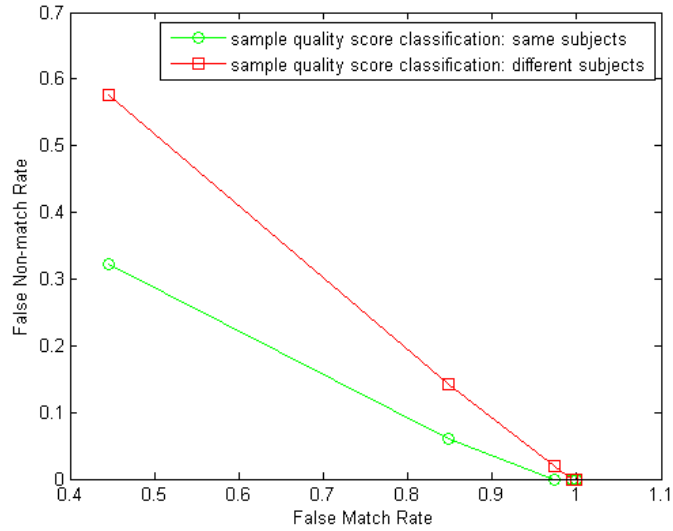
Figure 12. Example of two classification tests to verify the correlation in fingerprint images’ quality from two same-subject index fingers. Samples are from one session of the GUC100 database. Classification test 1 (green curve): same-subject index finger